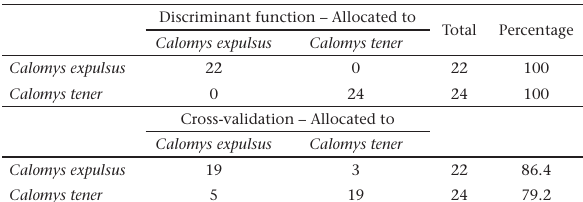
Table 2. Discriminant analysis results (classification/misclassification table) for Calomys expulsus and Calomys tener